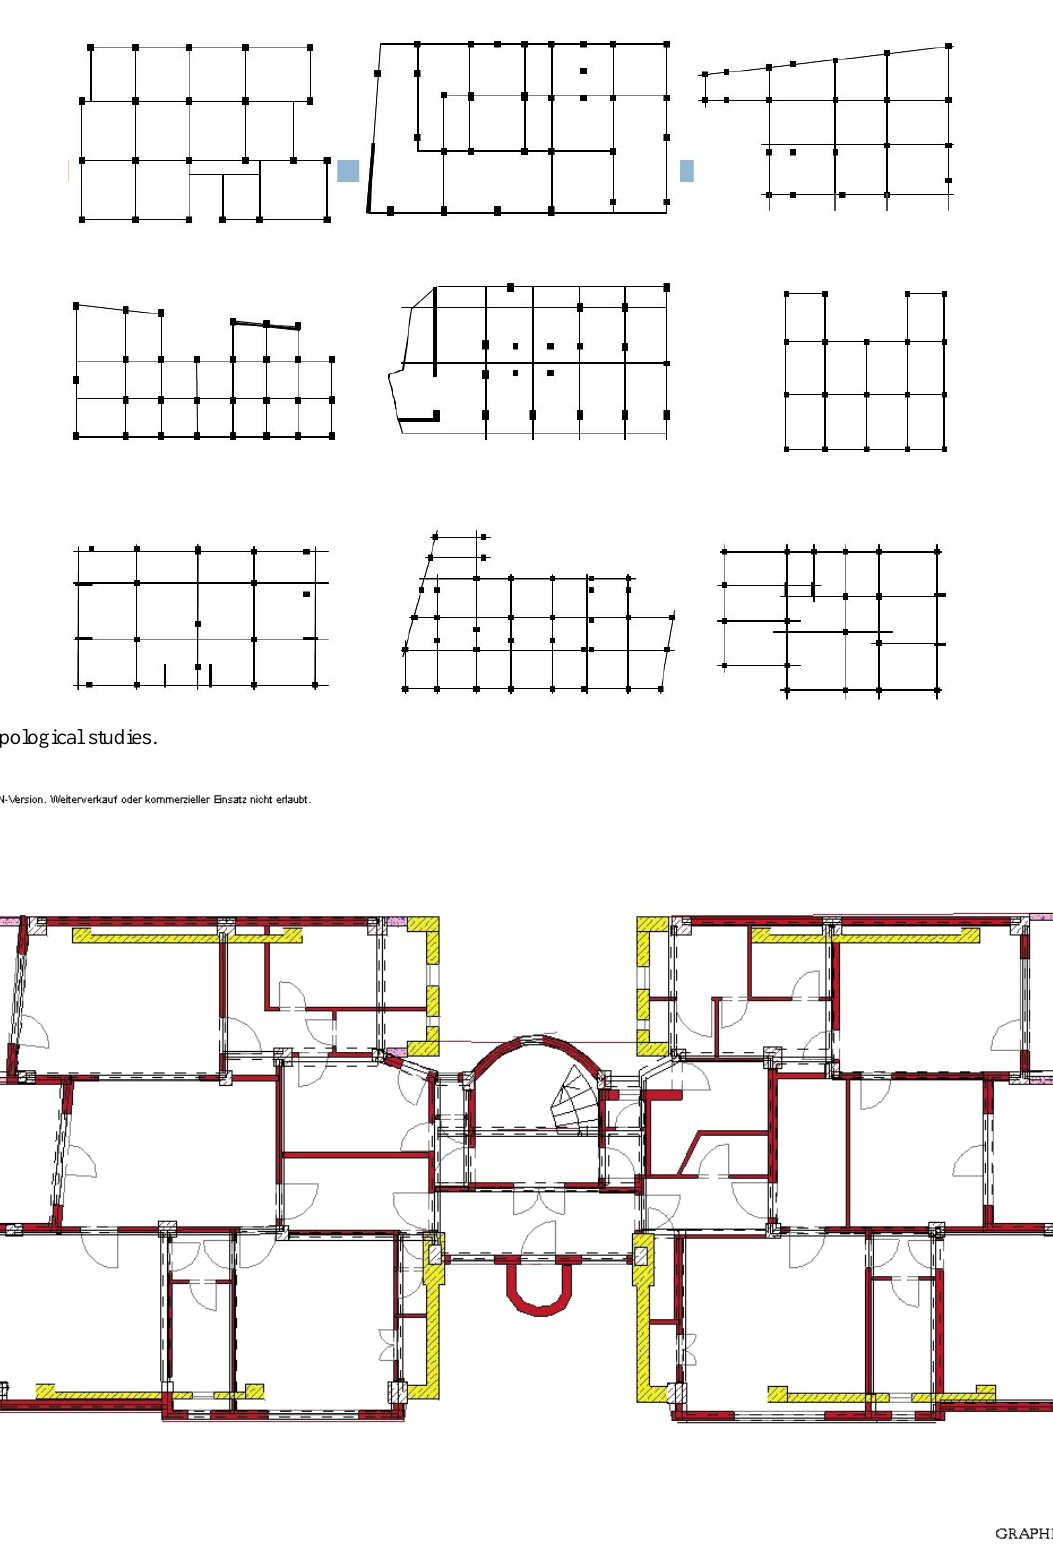
Figure 5. Model of Romanian interwar building in the World Housing